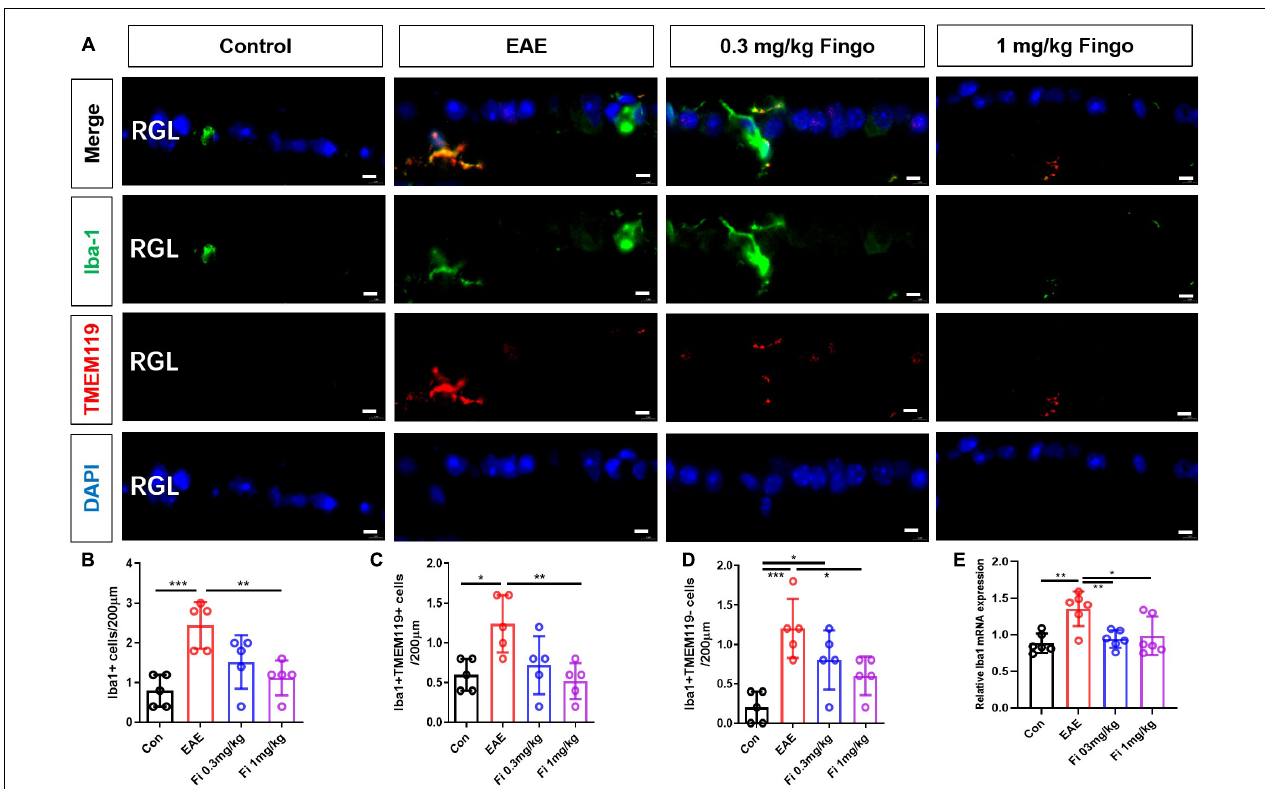
FIGURE 9 | Resident microglia and recruited macrophage numbers in the retina with fingolimod treatment. (A) Resident microglia and recruited macrophages were labeled with Iba1+ TMEM119+ and Iba1+ TMEM119- in the retina, respectively. (B) Comparison of microglia and macrophage numbers among groups in RGL (length = 200 µ m). (C) Comparison of microglia numbers among groups in RGL (length = 200 µ m). (D) Comparison of macrophage numbers among groups in RGL (length = 200 µ m). (E) Iba1 mRNA expression in retina RGL, retinal ganglion layer. Values are indicated as mean ± SD. One-way ANOVA plus Tukey’s multiple comparisons. * P < 0.05, ** P < 0.01, *** P < 0.001. Scale bar = 5 µ